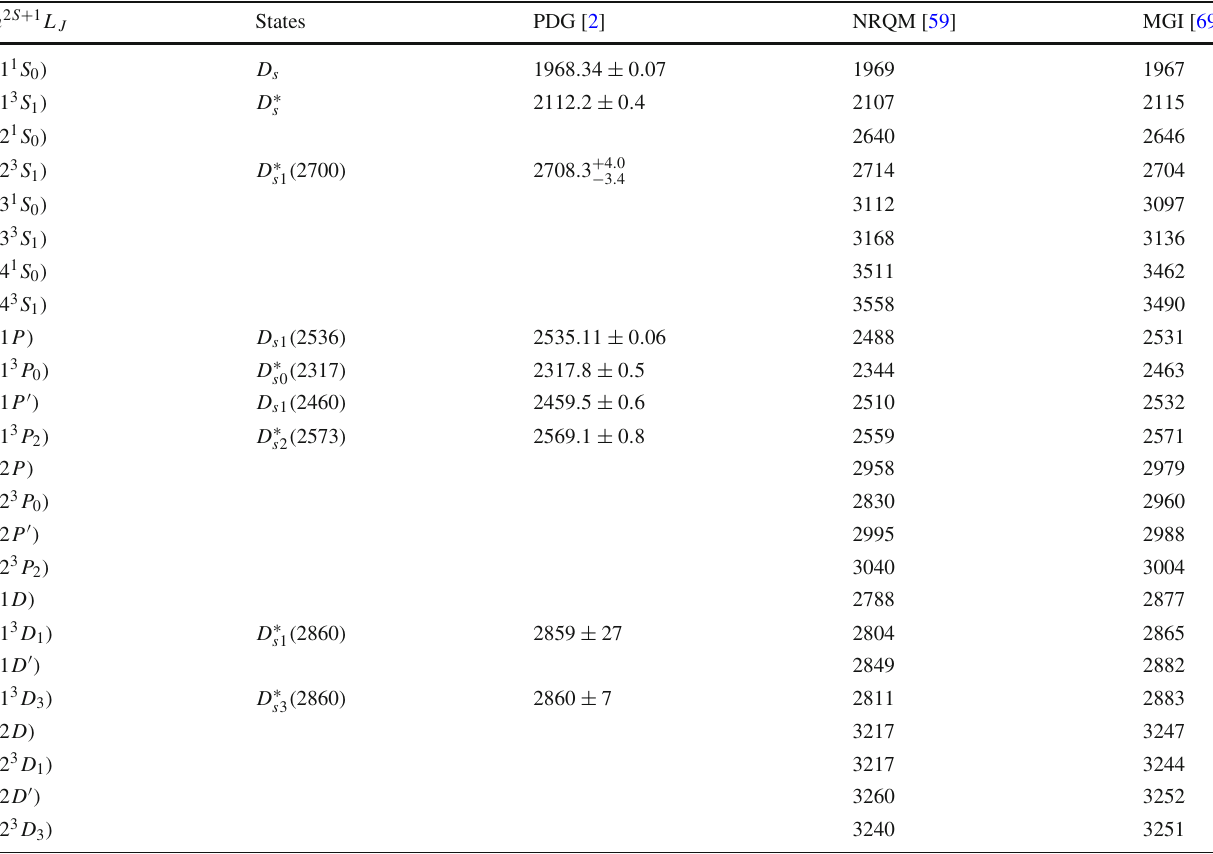
Table 3 The mass spectra (in MeV) of charmed-strange mesons obtained within the non-relativistic quark model (NRQM) and the modified Godfrey–Isgur Model (MGI) n 2 S + 1 L